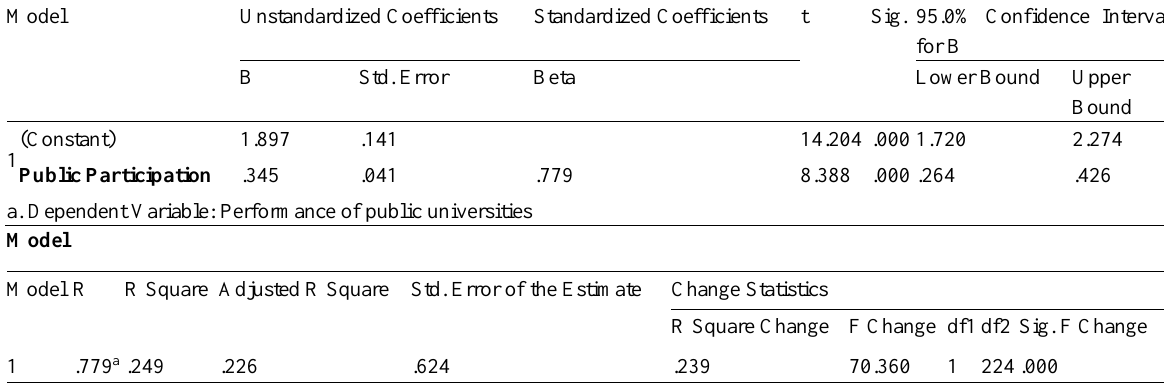
Table 6: Regression Results for the Effect of Public Participation on Performance of Public